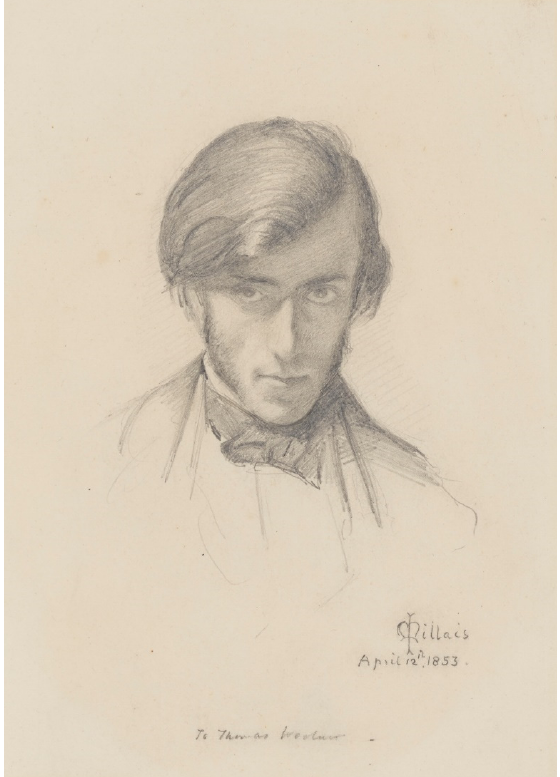
Figure 1. John Everett Millais , Frederic George Stephens , 1853 , pencil, 8 1/2 in. × 6 in. (216 mm × 152 mm) . Image ID: 2363 © National Portrait Gallery, London.